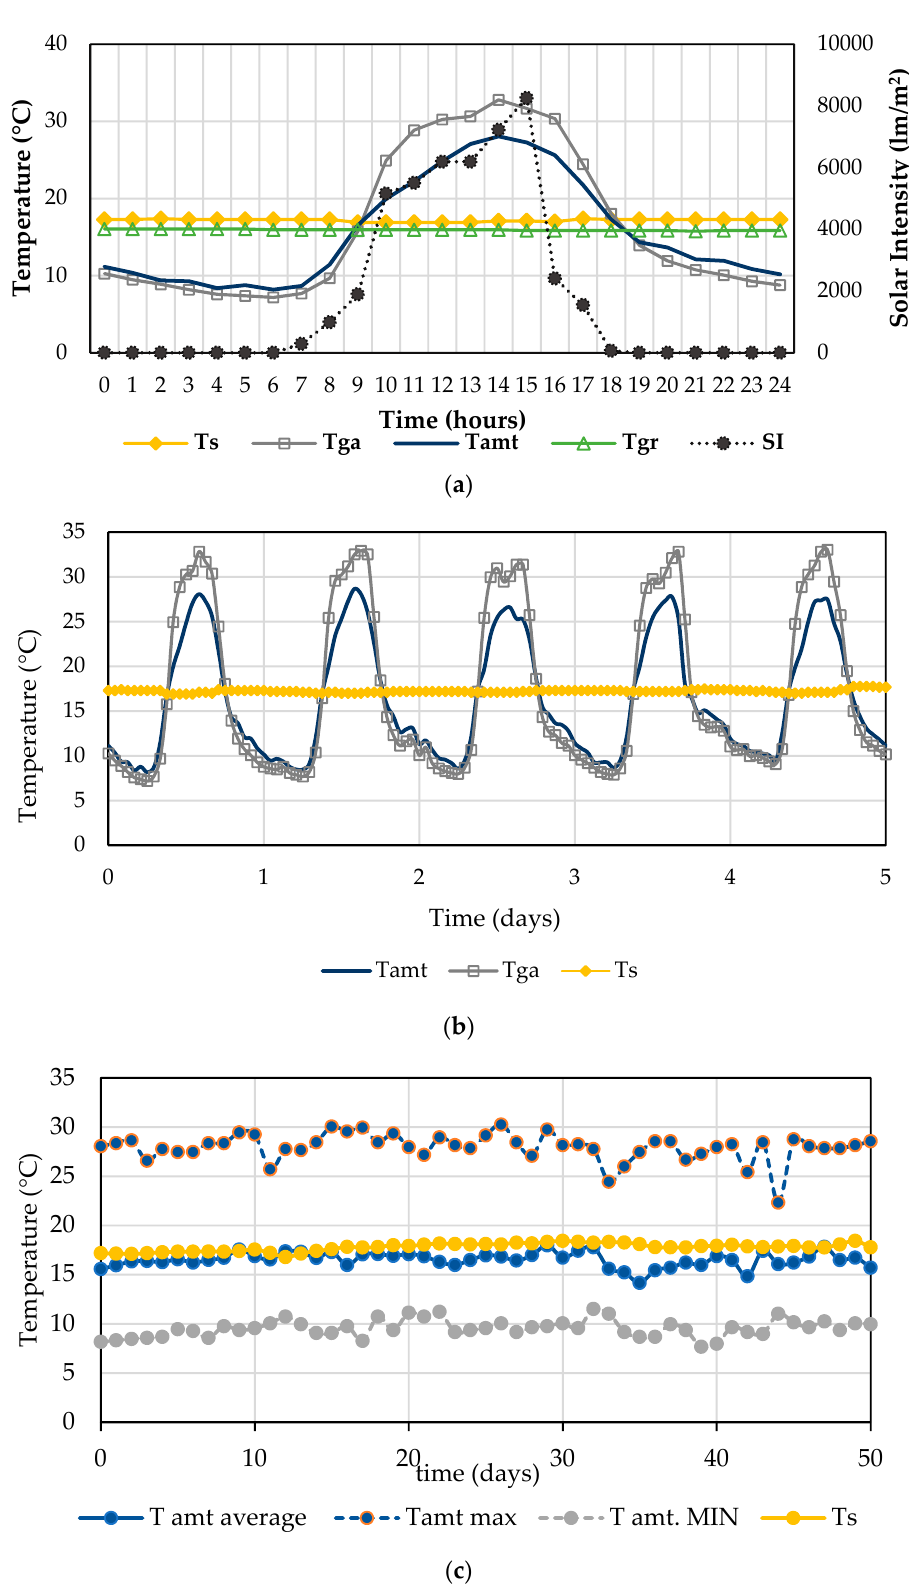
Figure 3. Thermal behavior of the digester. ( a ) Profiles of Ts, Tga, Tamt, Tgr, Tgh, Ts with solar luminosity for a day. ( b ) Profiles of Tamt, Tga, Ts for 5 days, ( c ) Behavior for 50 days of Tamt, Tamt max, Tamt min, Ts average. The slurry temperature (Ts) showed a flat performance with a mean temperature 17.7 °C, independent of daily variations (Figure 3b). The mean ground temperature (Tgr) was